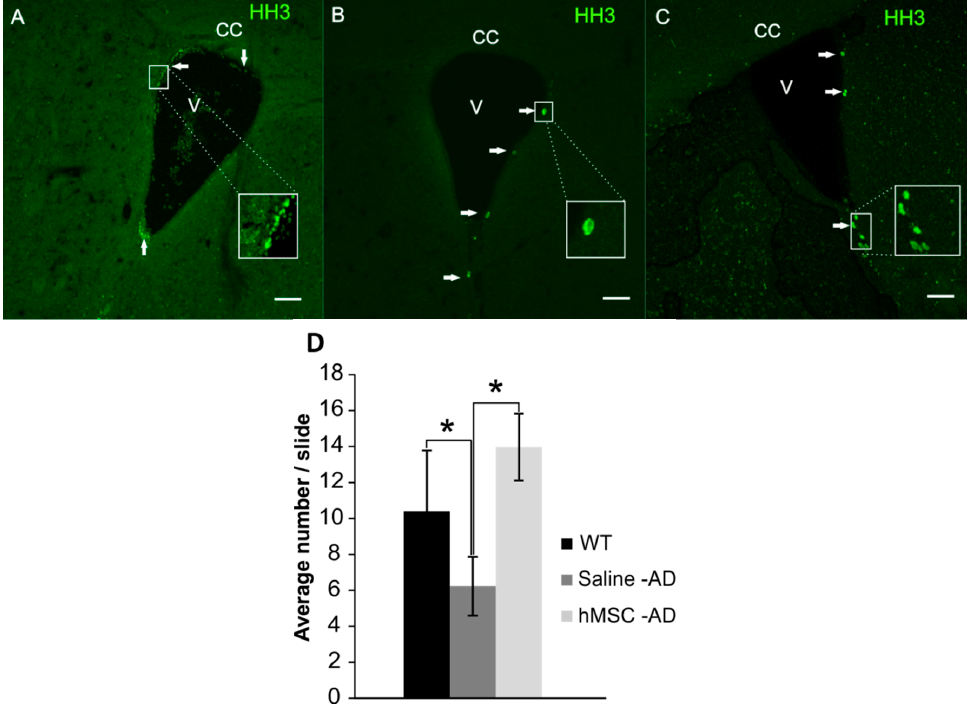
Figure 3. Neurogenesis in the subventricular zone (SVZ) in WT control animals ( A ); saline-treated 3xTg-AD mice ( B ); and MSC-treated 3xTg-AD mice ( C ). White arrows show histone H3 (HH3)-positive cells. Scale bar 50 μ m ( A – C ). The bar graph shows the mean number of HH3-positive cells/slice in the SVZ area ( D ). * p < 0.05. “CC”—Corpus Calosum; “V”—Ventricle.